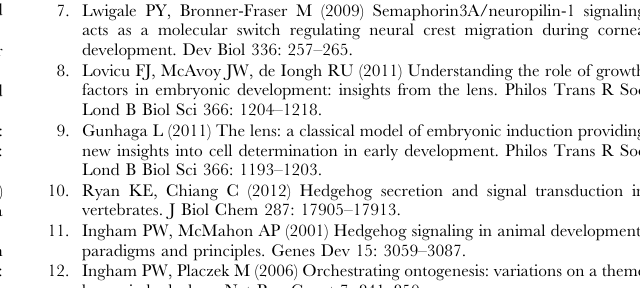
Figure S1 Loss of Smo expression in E14.5 Smox10 lenses. In situ hybridisation for Smo mRNA in Wt ( A ) and Smox10 ( B ) lenses. In Wt lenses, Smo mRNA is detected in lens epithelial (le) cells and early differentiating fibres (lf) below the equator (dashed line). Scale bar, 150 m m. (TIF) Figure S2 Smox10 lenses develop normally. Comparison of Wt ( A, C, E, G ) and Smox10 ( B, D, F, H ) lenses at E13.5, by Haematoxylin & Eosin stain ( A, B ) and immunolabelling for E- cadherin ( C, D ), b -crystallin ( E, F ) and phospho-histone 3 ( G, H ), show no abnormal changes in the Smox10 lenses. Scale bar, A–B , 200 m m; C–H , 100 m m. (TIF) Figure S3 Loss of Smo expression in LeSmox lenses. In situ hybridisation for Smo mRNA in Wt ( A ) and LeSmox ( B ) lenses at E11.5 and RT-PCR ( C ) for Smo and Hprt in isolated E13.5 lenses, showing loss of Smo expression in LeSmox mutants. In Wt lenses at E11.5 ( A ), Smo mRNA is detected in the early lens pit/vesicle, particularly in the anterior vesicle cells (arrowheads) but also in the optic cup. B. In the LeSmox mutants at E11.5 signal for Smo mRNA is decreased in the lens pit. C. In the LeSmox mutants at E13.5, no expression of Smo is detected in isolated E13.5 lens vesicles by RT-PCR. Plus ( + ) and minus ( 2 ) signs indicate presence or absence of reverse transcriptase, respectively. Scale bar: 50 m m ( A, B ).